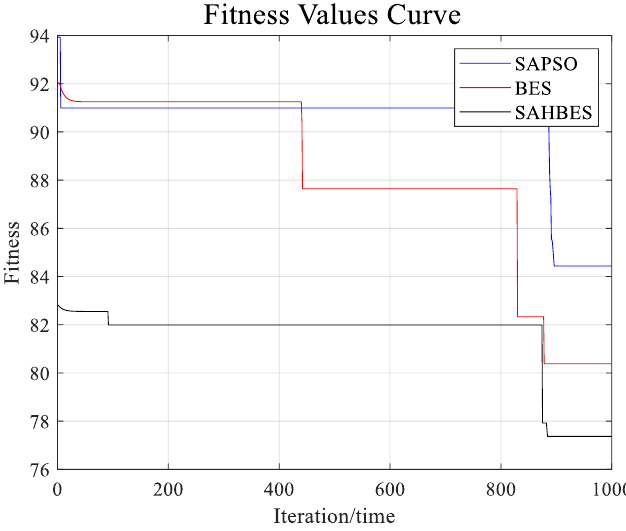
Figure 9. Global path planning chart of trap obstacles simulation I.